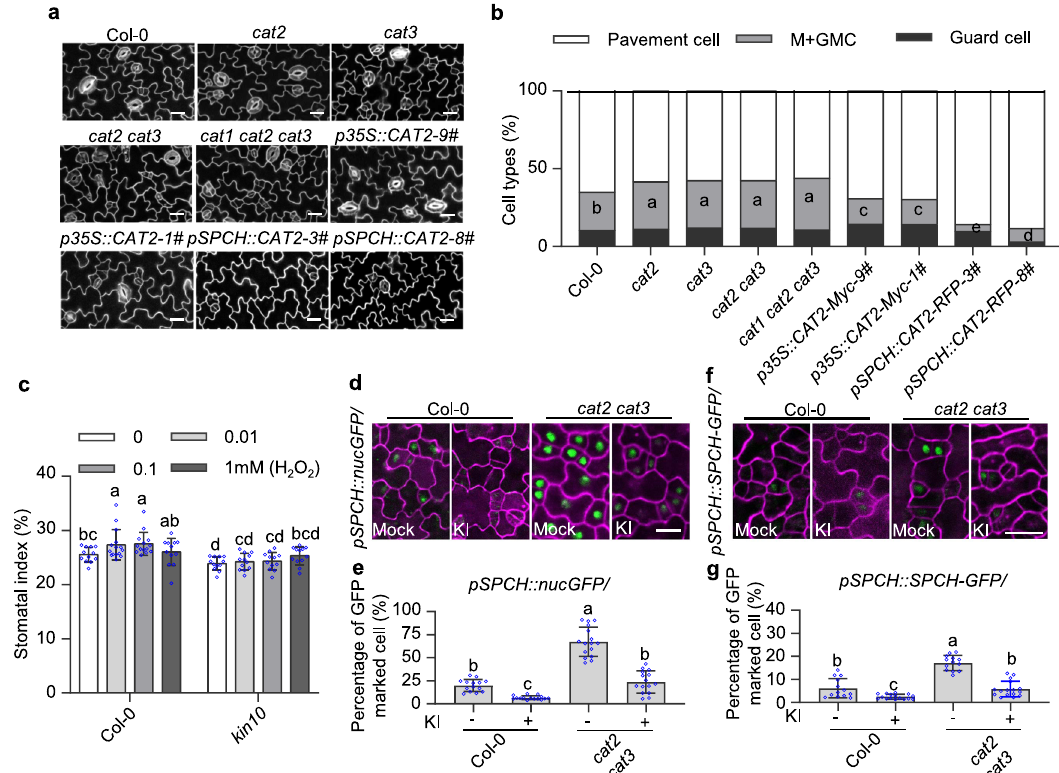
Fig. 4 | H 2 O 2 promotes stomatal development. a , b Quanti fi cation of epidermal cell types of Col-0 and indicated plants, expressed as percentage of total cells. GMC, guard mother cell; M, meristemoid. n =13, 14, 14, 14, 14, 14, 15, 15, 12 inde- pendentcotyledonswereexaminedin b .Seedlingsofwild-typeCol-0andindicated plants were grown on ½ MS solid medium containing 1% sucrose under 16h light/ 8hdarkphotoperiodwith100 µ Mol/m 2 /sfor5days. c ,Quanti fi cationoftheeffects of H 2 O 2 on stomatal index. n =12, 15, 14, 12 (Col-0), n =12 ( kin10 ) independent plants were examined in c . Seedlings of wild-type Col-0 and kin10 mutant were grown on ½ MS solid medium containing 1% sucrose and different concentrations of H 2 O 2 under 16h light/8h dark photoperiod with 100 µ Mol/m 2 /s for 8 days. d – g CAT mutations altered cell fate in Arabidopsis epidermis. n =14, 15, 16, 15 inde- pendent cotyledons were examined in e . n =13, 16, 13, 16 independent cotyledons